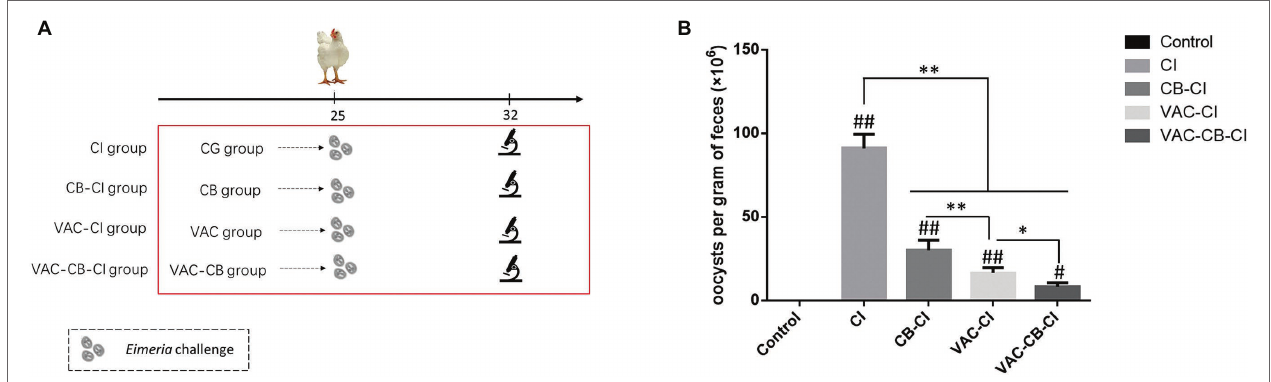
FIGURE 2 | Technical roadmap (A) and oocysts per gram (B) of different pretreated chickens following Eimeria sp. challenge. The five experimental groups were CG, CI, CB-CI, VAC-CI, and VAC-CB-CI groups. The latter four groups were randomly taken from the CG, CB, VAC, and VAC-CB groups and then challenged with Eimeria sp. Significant differences between groups are shown by asterisks: * p < 0.05; ** p < 0.01. Significant differences between treatment groups and the control group are indicated by the hash symbol: # p < 0.05; ## p <